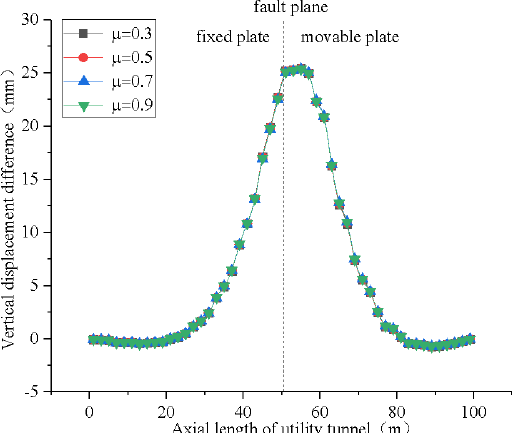
Figure 14. Vertical displacement difference distribution curve.